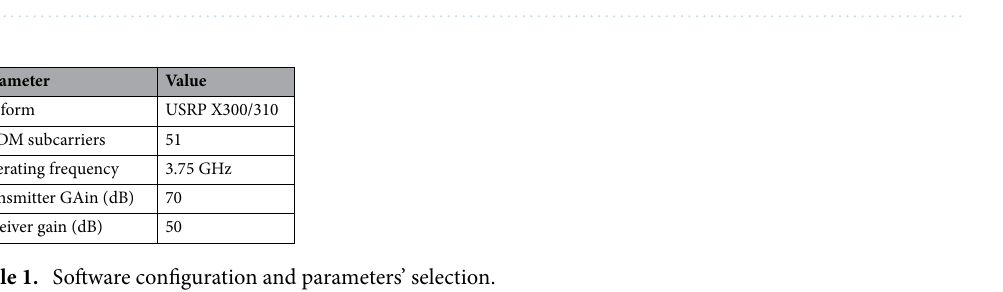
Figure 2. System concept diagram showing the contactless sensing system for multi-users using wireless signals.